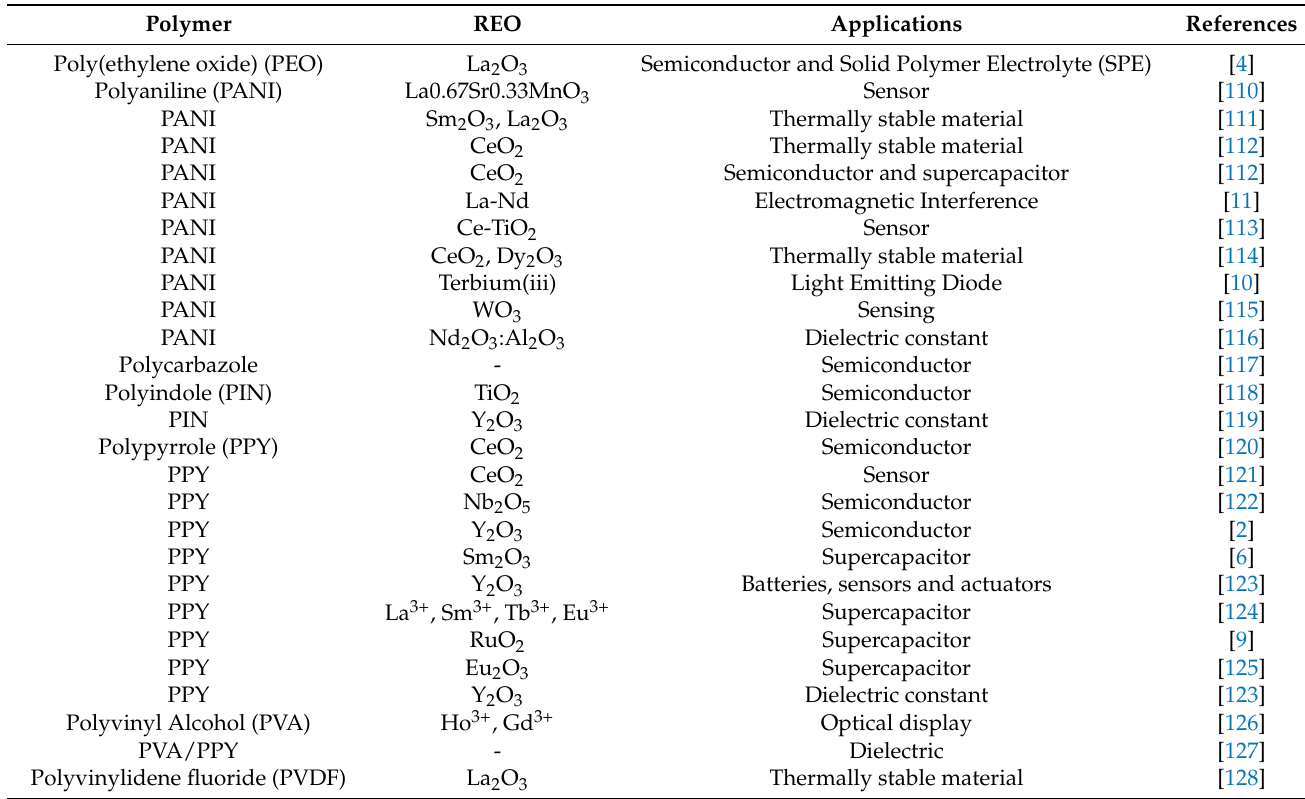
Table 1. Applications of various rare earth oxides based conducting polymer